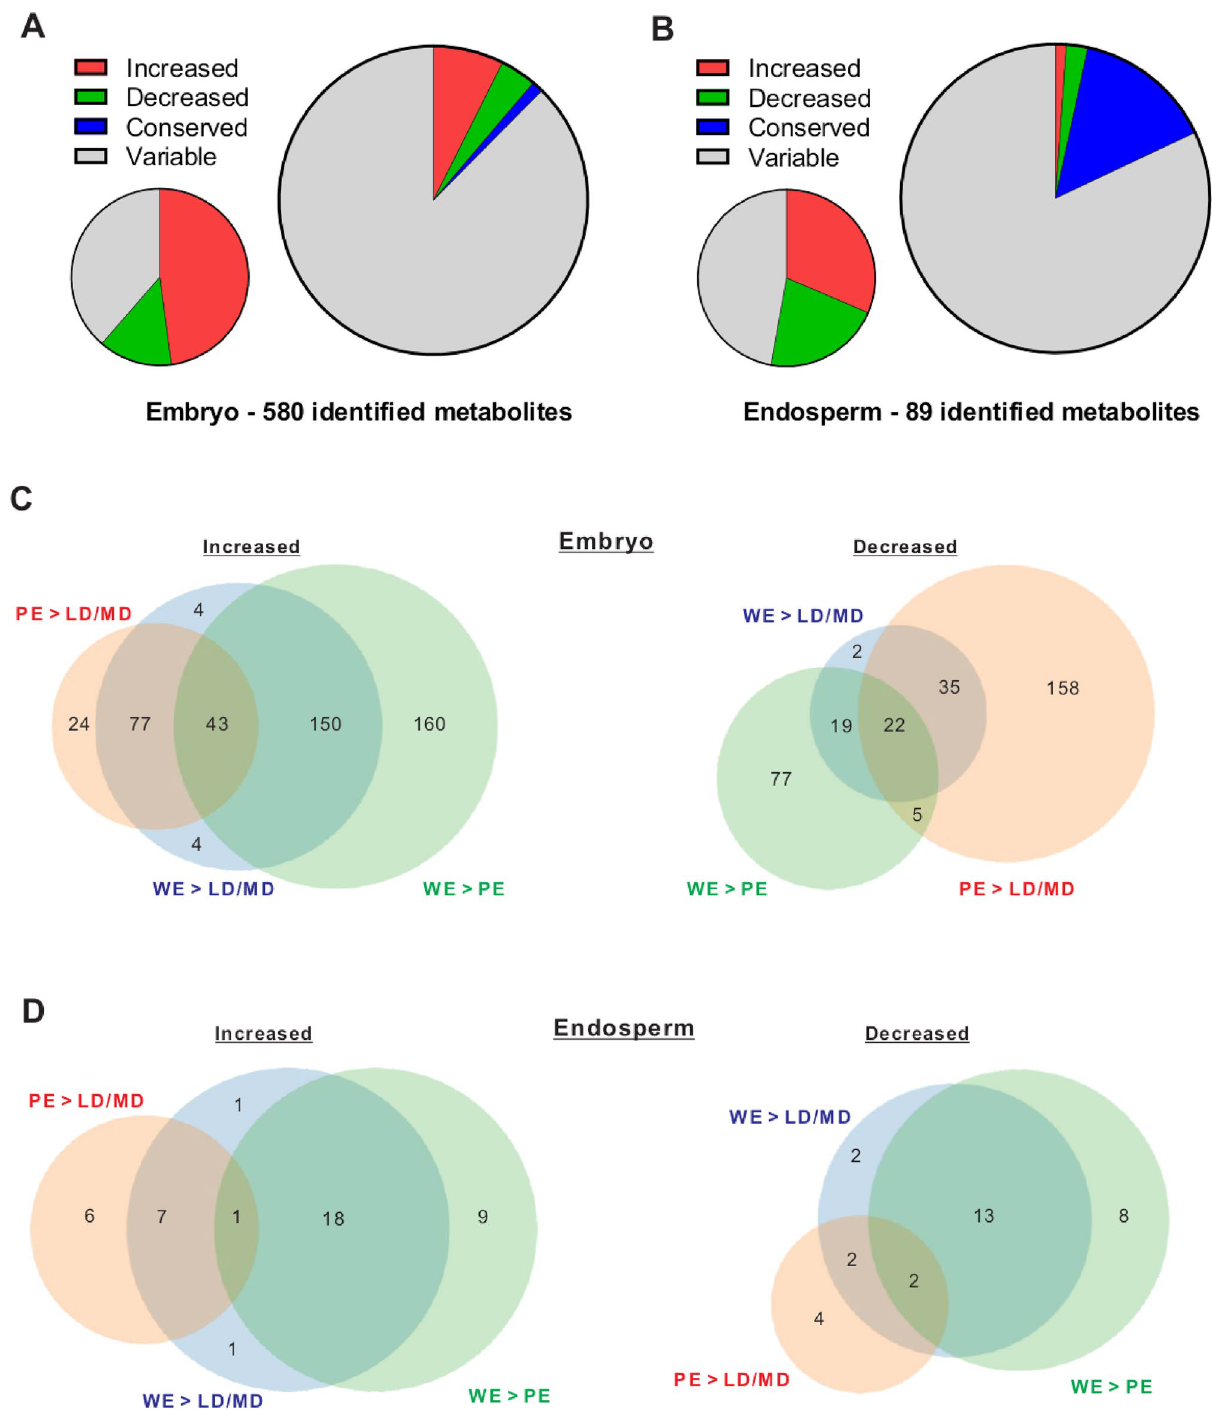
Figure 2. Comparative metabolomics. Identified metabolites that underwent significant changes in association with wheat domestication. Each metabolome is a result of group-averaged metabolite values from all the replicas and wheat lines that belong to that group. A statistical comparison is made between each pair of groups from a total of 4 groups: WEW—wild emmer; WED (PE)— primitive emmer; LD—landraces durum; MD—modern durum. ( A,C ) Comparison of embryo metabolomes. ( B,D ) Comparison of endosperm metabolomes. ( A-B ) Small pie charts—comparisons between the WE group and the LD/MD groups. Metabolites that underwent a significant increase or decrease in two comparisons (WE to LD and WE to MD). Variable metabolites either did not undergo statistically significant changes or did not increase or decrease in both comparisons. Large pie charts—comparisons between the WE, PE group and the LD/MD groups. Metabolites that underwent a significant increase or decrease in three comparisons (WE to PE, PE to LD and PE to MD) were considered to be steadily changed metabolites. Conserved metabolites did not undergo any statistical changes in any comparison. Variable metabolites did not undergo a steady increase or a steady decrease in all three comparisons. ( C-D ) Venn diagrams depict the numbers of statistically changed metabolites in the following comparisons: WE to PE, PE to both LD and MD, and WE to both LD and MD, and steadily changed metabolites. Increased metabolites on the left and decreased metabolites on the